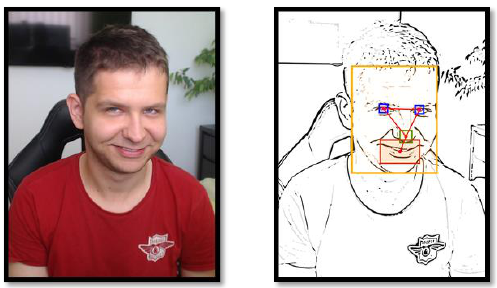
Figure 2. Specific facial parameters